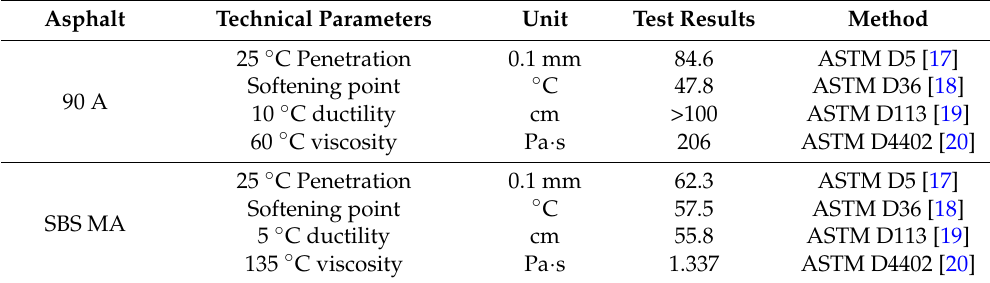
Table 1. Properties of 90 A and SBS